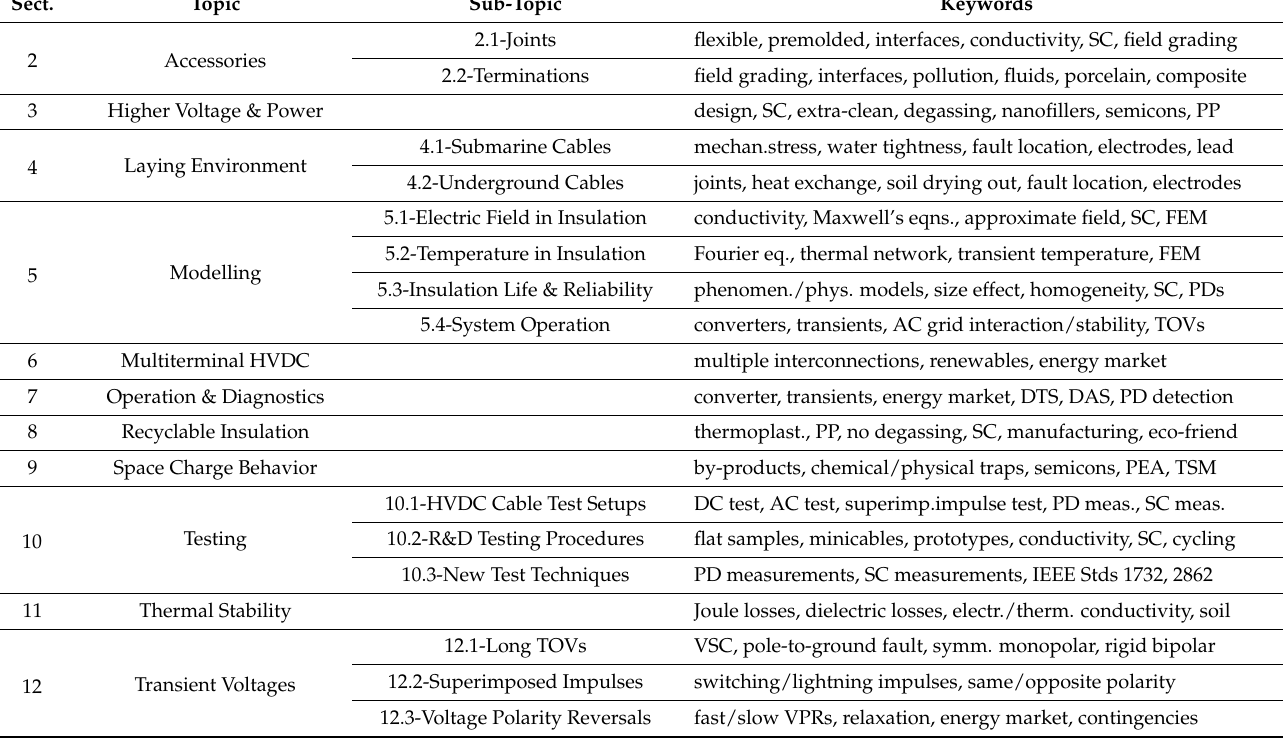
Table 1. Alphabetical order list of topics/subtopics treated in the paper with the relevant Sections.